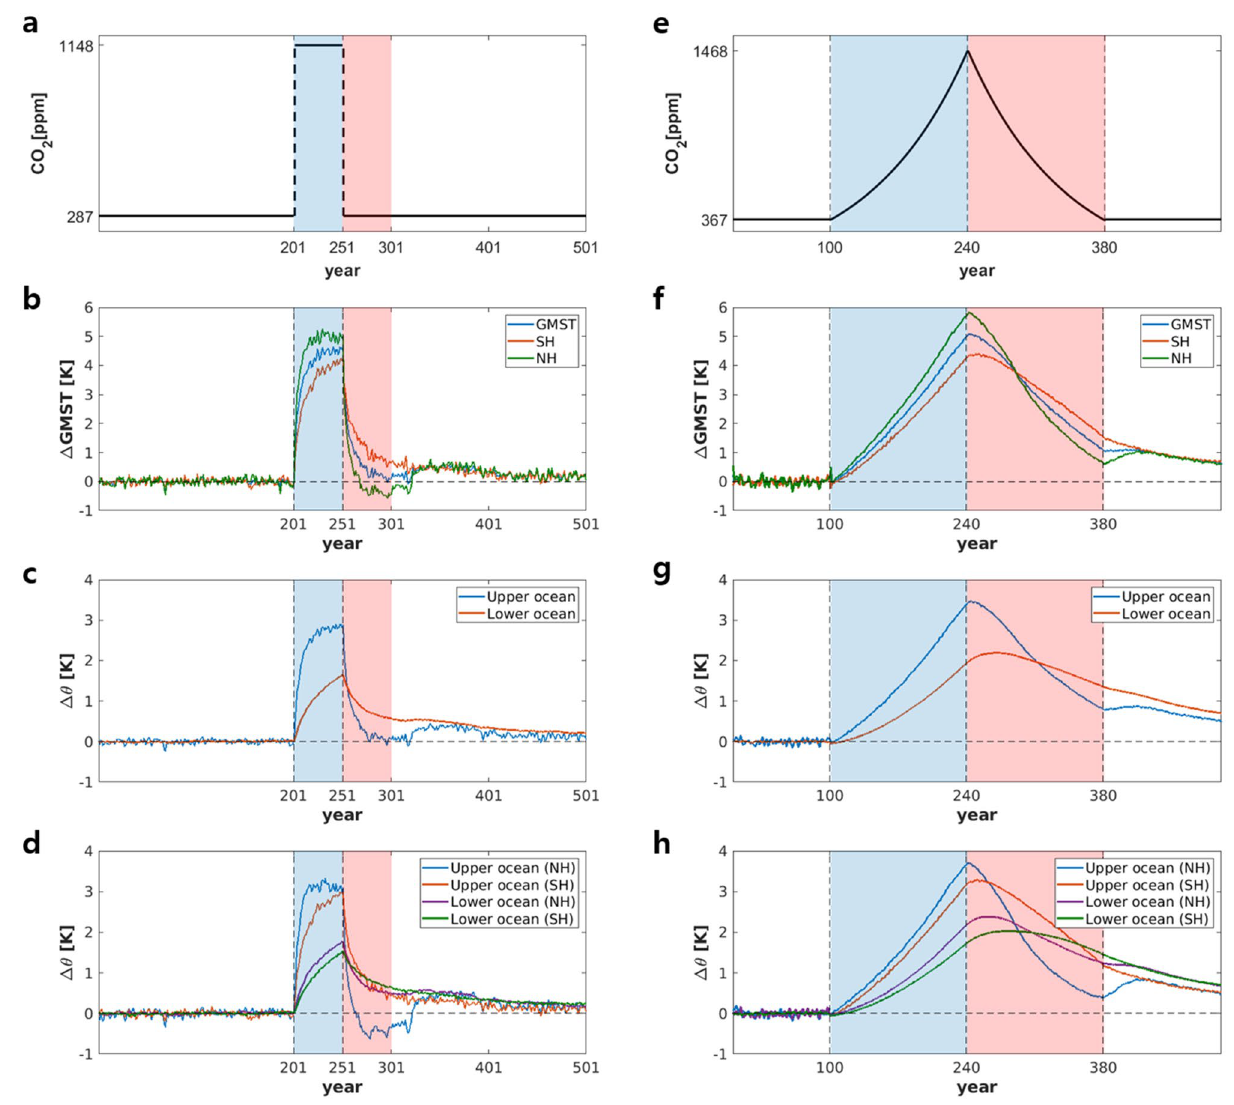
Figure 1. Time series obtained from 4 × CO 2 PLS experiment for ( a ) atmospheric CO 2 concentrations, ( b ) deviations in the global mean surface air temperature (GMST) and hemisphere-averaged surface air temperature, ( c ) deviations in global mean potential temperature in the upper and lower oceans, ( d ) deviations in hemisphere-averaged potential temperature in the upper and lower oceans, from corresponding means of the pre-industrial runs. ( e – h ) As in ( a – d ), respectively, for 4 × CO 2 CDR experiment. Blue and red shaded portions indicate 50-year periods when forcing was switched on (ON50Y) and off (OFF50Y) for ( a – d ), respectively, and ramp-up and ramp-down periods for ( e – h ), respectively. Units are represented on the scales in each